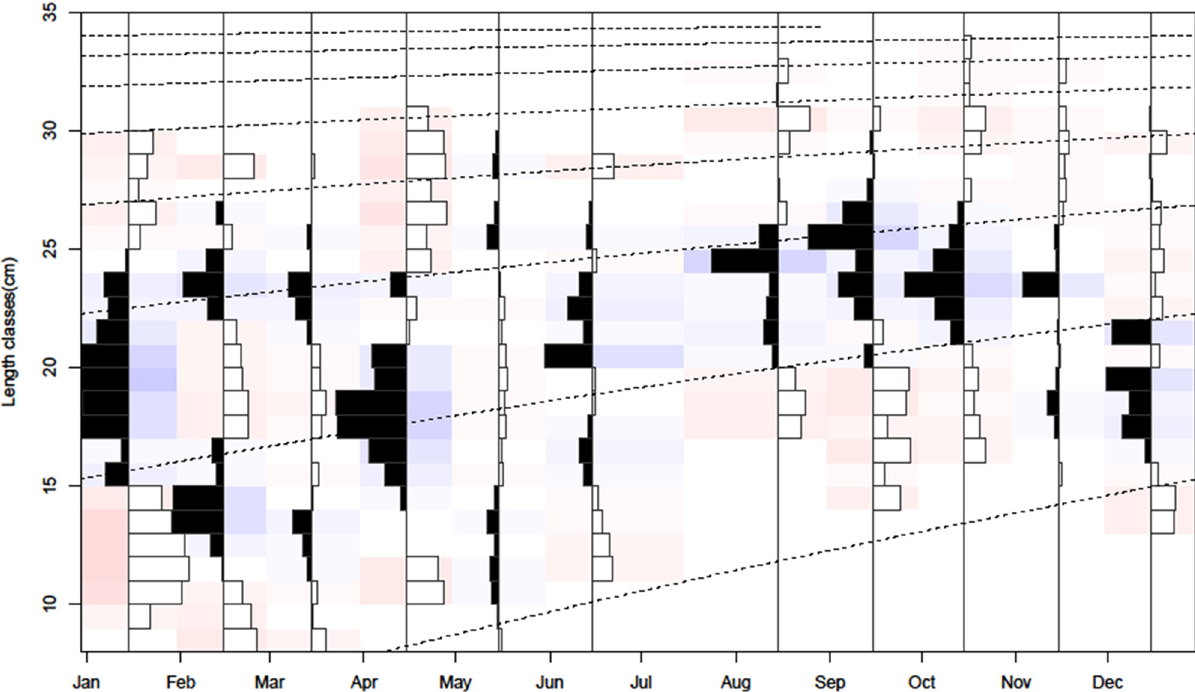
Fig. 3. von Bertalanffy growth curves estimated using restructured length-frequency data for S. undosquamis from southeastern Arabian Sea by ELEFAN I during 2012 – 2016.